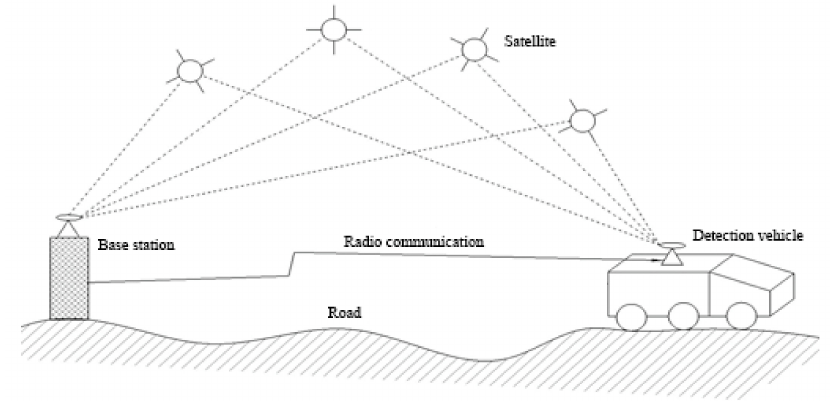
Figure 4. Principle of RTK detection.